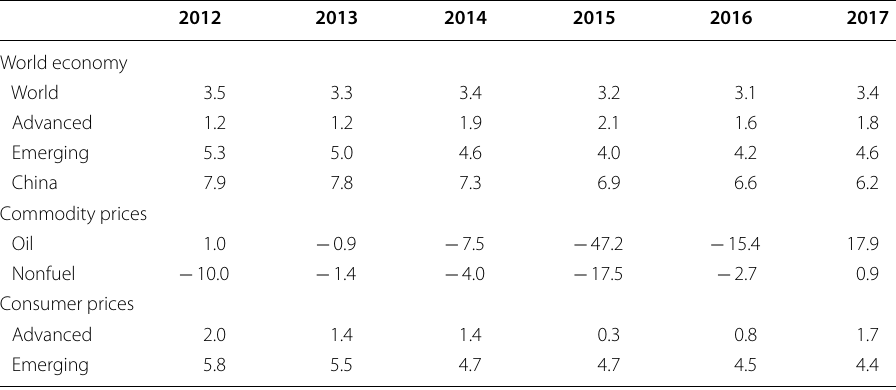
Table 1 World economy, commodity prices and consumer prices (%, y-on-y). Source :